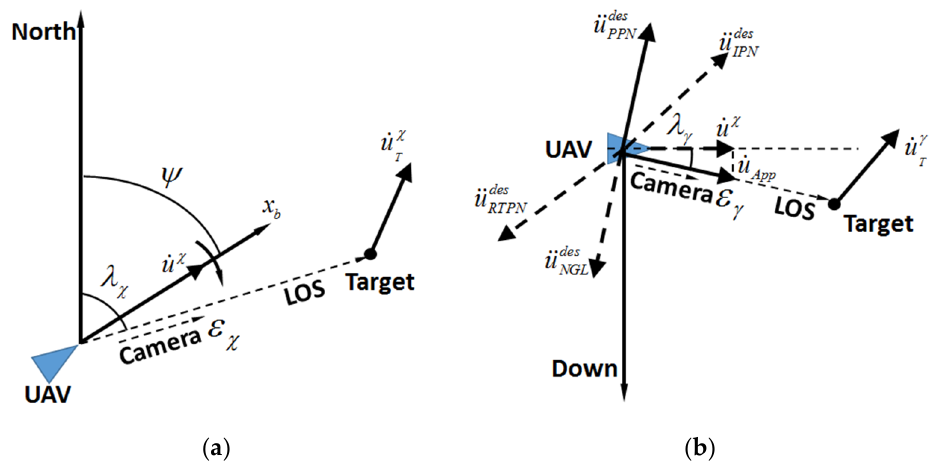
Figure 12. Schematic diagram showing the tracking strategy. ( a ) description of tracking the lateral LOS angle based on a pure pursuit method; ( b ) description of tracking the longitudinal LOS angle based on PN guidance law.